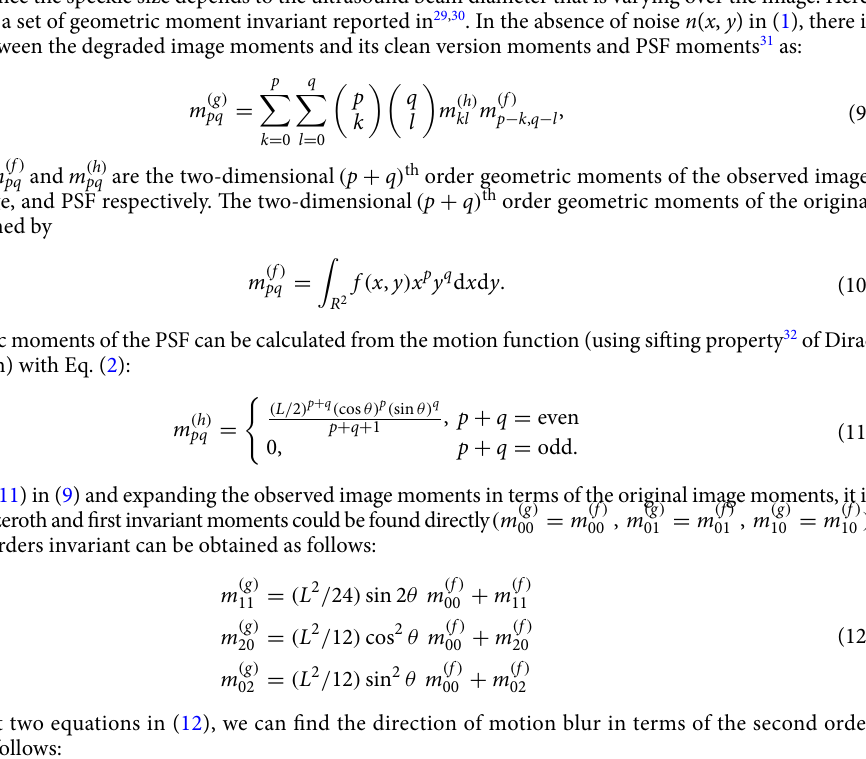
Figure 4. PSF of motion blur in the Fourier domain for different lengths ( L 30 , 45 , 60 , 85 (θ ◦ ◦ ◦ ◦ ) =